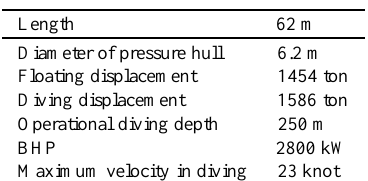
Table 2 Principal specifications of the U209